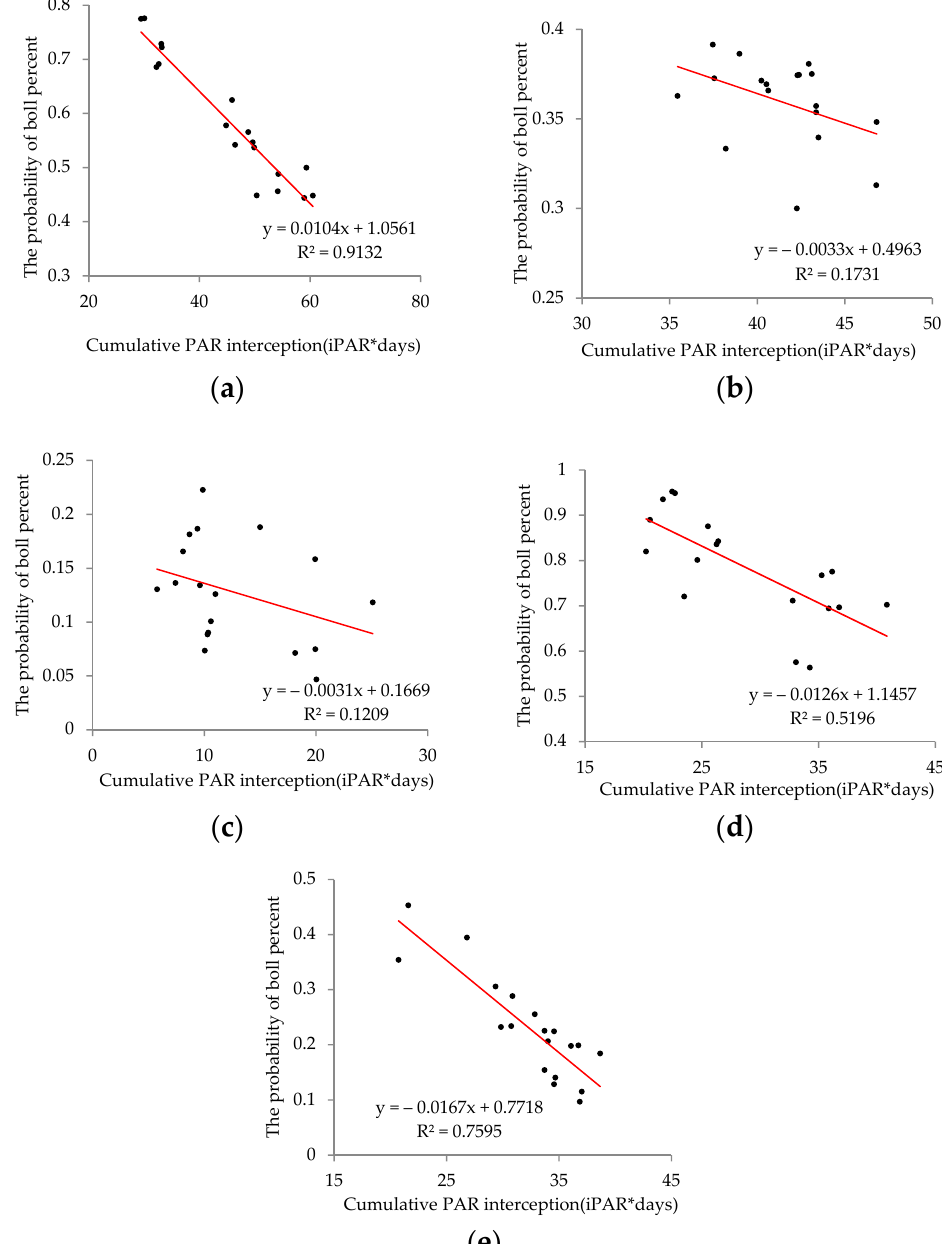
Figure 10. Relationships between cumulative light interception and the boll retention rate in the corresponding section. ( a ) Lower; ( b ) Middle; ( c ) Upper; ( d ) Inner; ( e ) Outer. iPAR*days means iPAR's integral of the number of growth days.